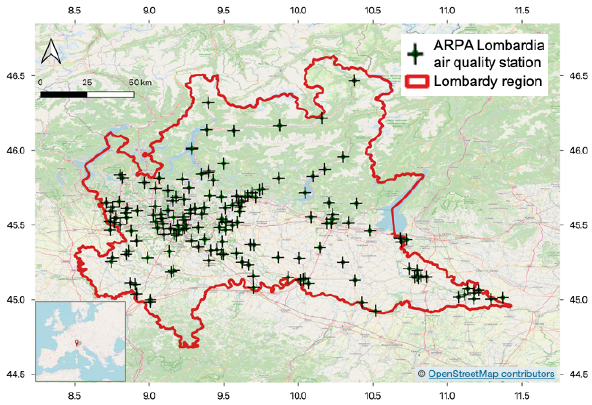
Figure 3 . Locations of ARPA Lombardia Air Quality